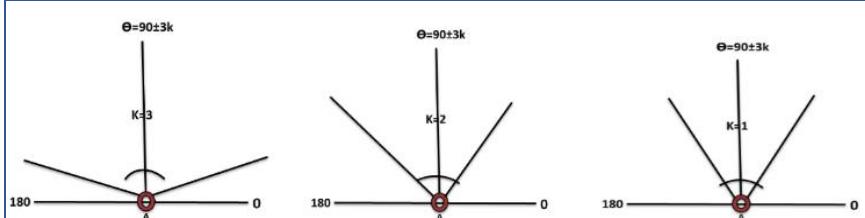
Figure 4. Possibility of angle flooding zone when Node Uses K = 1, 2 and 3.